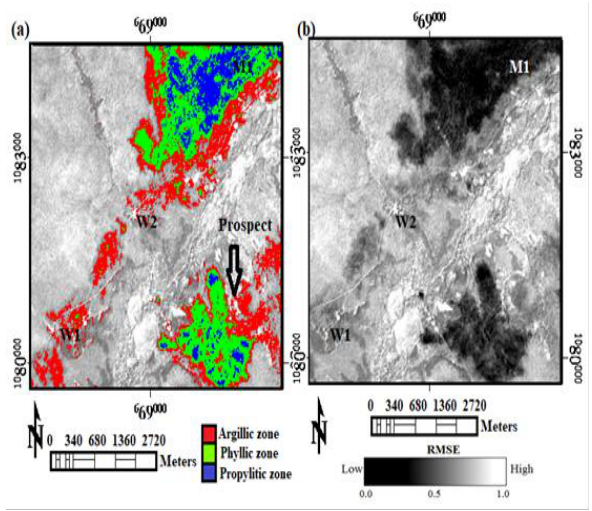
Figure 4: (a) LSU subpixel abundance image using image spectra (Wikki roi). (b) RMSE for image in (a) The result also identified areas verified in the field at W1, W2 and M1 which are exposed altered zones as observed in the NDVI image of the subset area (see figure 3b). The RMSE image in figure 4(b) is used to assess accuracy of the result which shows errors as bright pixels and dark pixels as good fit (Van Der Meer, 1999). The RMSE image indicates a good agreement with the abundance image as areas discriminated as alteration zones correspond to dark pixels in the error image signifying possible valid detections.